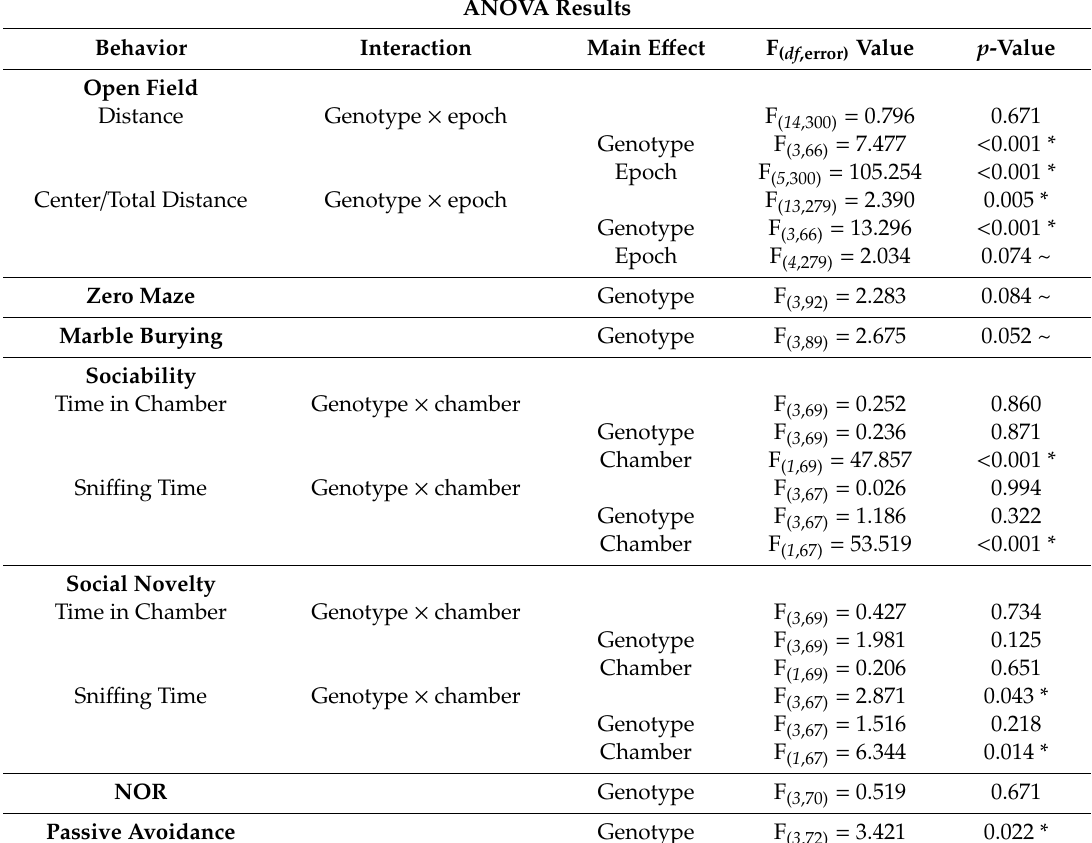
Table 1. Results of repeated measures ANOVA for behavior testing with corresponding F-values